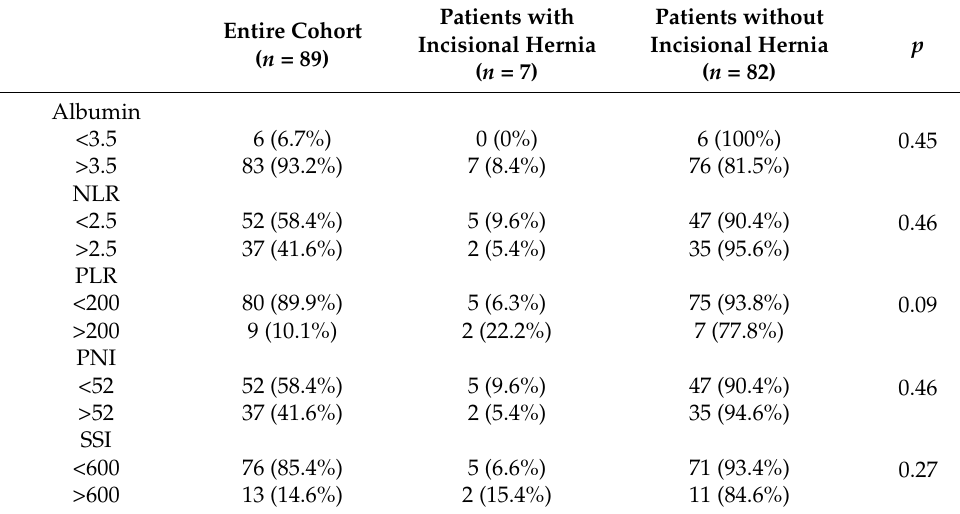
Table 2. Preoperative blood test and nutritional indices.